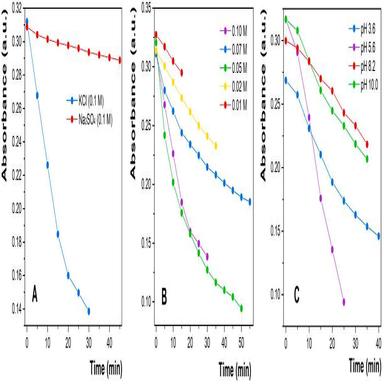
A) Effect of the supporting electrolyte for the removal of the RB52; B) Effect of the concentration of the supporting electrolyte for the removal of the RB52; C) Effect of the starting pH for the removal of the RB52.